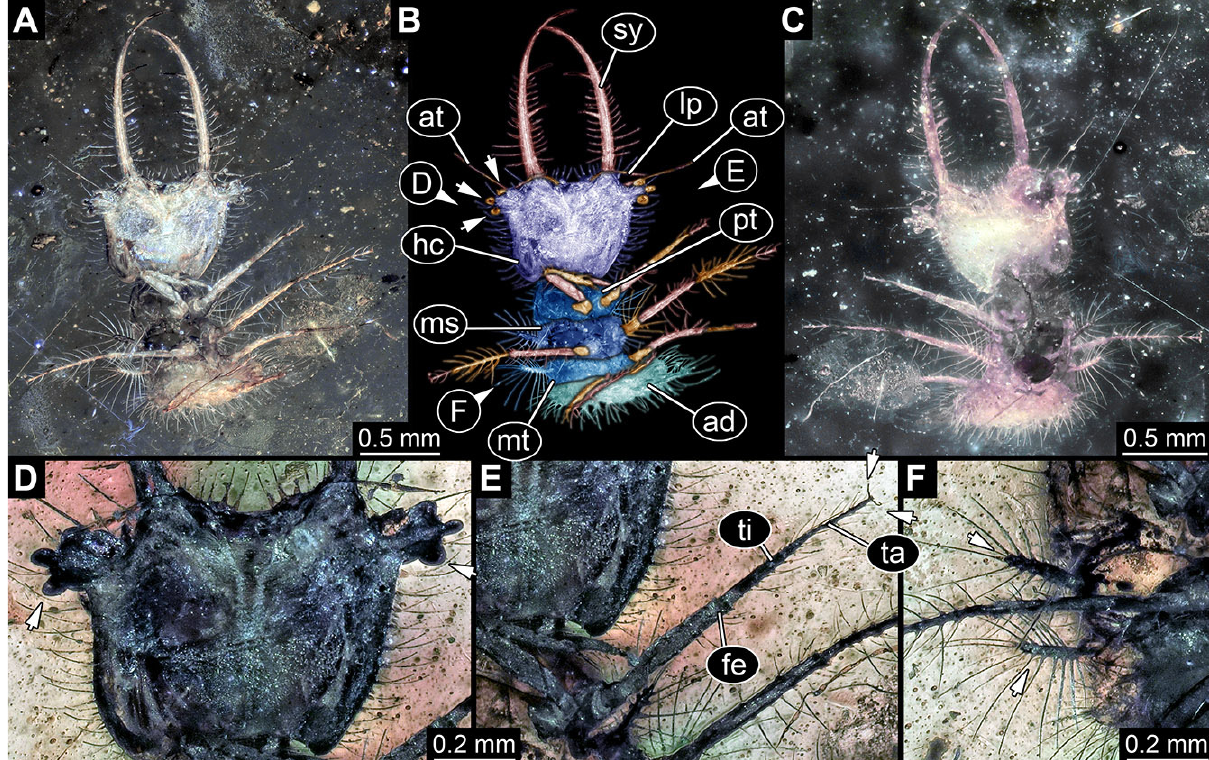
Figure 5. Fossil owllion larva, specimen 3216 (BUB 3343), Cretaceous Kachin amber, Myanmar. ( A ) Overview, ventral. ( B ) Color-marked version of ( A ); arrows mark stemmata. ( C ) Overview, dorsal. ( D ) Close-up on head capsule with fields of stemmata (arrows). ( E ) Close-up on locomotory appendages with distal claws (arrows). ( F ) Close up on dorsal processes (arrows). Abbreviations: ad = abdomen; at = antenna; fe = femur; hc = head capsule; lp = labial palp; ms = mesothorax; mt = metathorax; pt = prothorax; sy = stylet; ta = tarsus; ti = tibia.